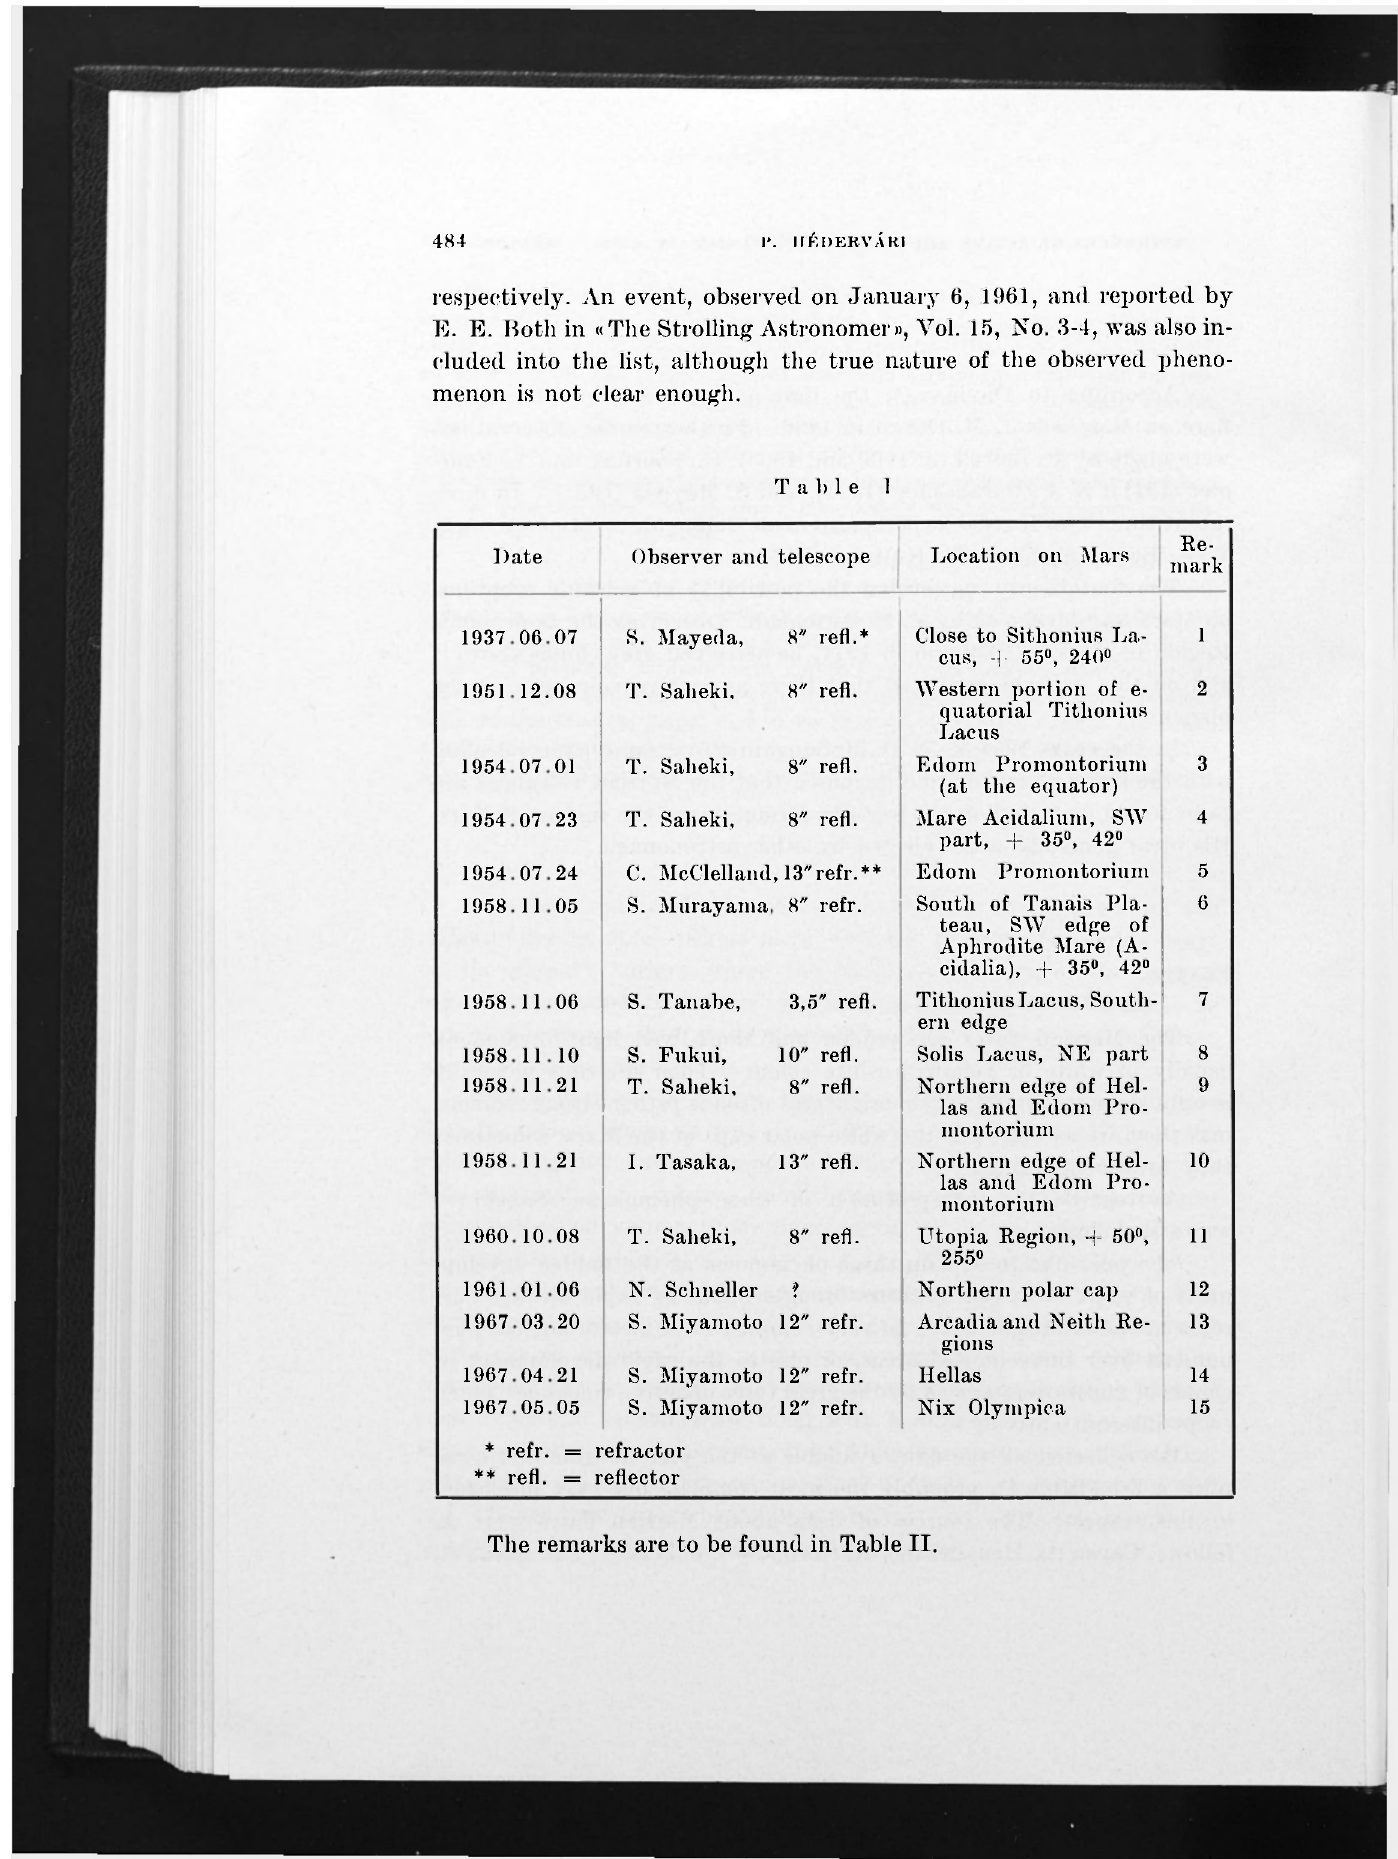
respectively. An event, observed on J a n u a ry 6, 1961, a nd reported by E. E. Both in «The Strolling Astronomer», Vol. 15, No. 3-4, was also in- cluded into the list, although the true n a t u re of t he observed pheno- m e n on is not clear